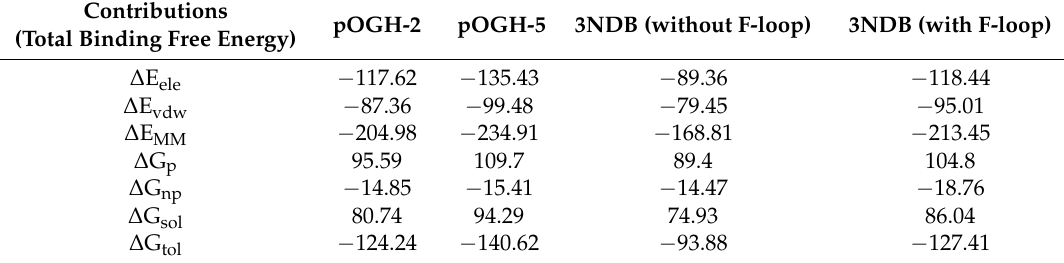
Table 3. Molecular mechanics generalized born surface area (MM-GBSA) binding free energy results for pOGH-2 and pOGH-5 (kcal mol − 1 ) together with the reference structures with or without the finger